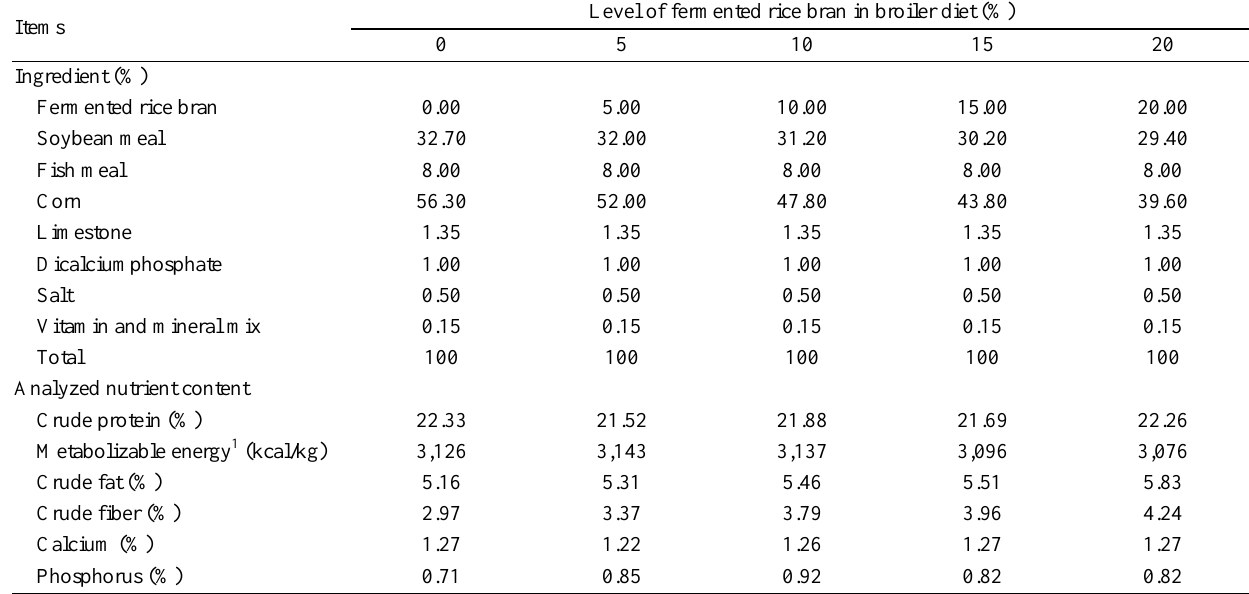
Table 1. Ingredients and chemical composition of diets provided during experiments Items